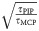
Torque ratios among proximal interphalangeal (PIP) and metacarpophalangeal (MCP), and carpometacarpal (CMC) joints in digit III during a cylindrical grip or suspensory hand posture.τPIPτMCP (A), τMCP#τPIP# (B), τPIPτCMC (C), and τMCPτCMC (D) during cylindrical grip are compared among the arboreal group, terrestrial quadrupedal group, and Homo sapiens. τPIPτMCP (E), and τMCP#τPIP# (F) during suspensory hand posture was also compared among brachiating, and terrestrial quadrupedal primates, and H. sapiens. Ph cross-ratio, the cross-ratio calculated from the proximal, middle, and distal phalangeal lengths; r1, diameter of the cylinder relative to the sum of the lengths of the proximal, middle, and distal phalanges; τCMC, τMCP and the τPIP torques loaded on the CMC, MCP and PIP joints, respectively; τMCP# and τPIP# the torques loaded on the MCP and PIP joints, respectively, when the force loaded on the distal phalanx is not considered. *P< 0.05, **P< 0.01, arboreal or brachiating primates versus terrestrial quadrupedal; §P < 0.05, §§P < 0.01, arboreal or brachiating primates versus H. sapiens, ¶P < 0.05, ¶¶P < 0.01, terrestrial quadrupedal versus H. sapiens, using Scheffe’s post hoc test.